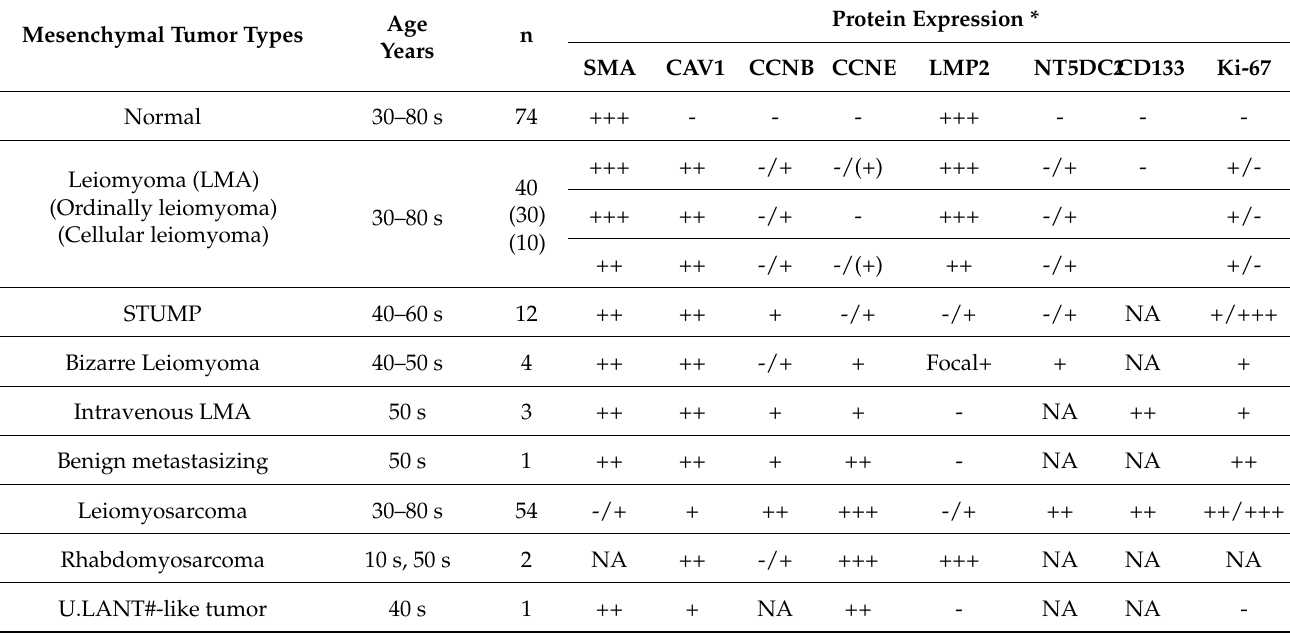
Table 1. Differential expressions of SMA, caveolin-1, cyclin B, cyclin E, LMP2, NT5DC2, CD133, and Ki-67 in human uterine mesenchymal tumors and uterine LANT-like tumor.